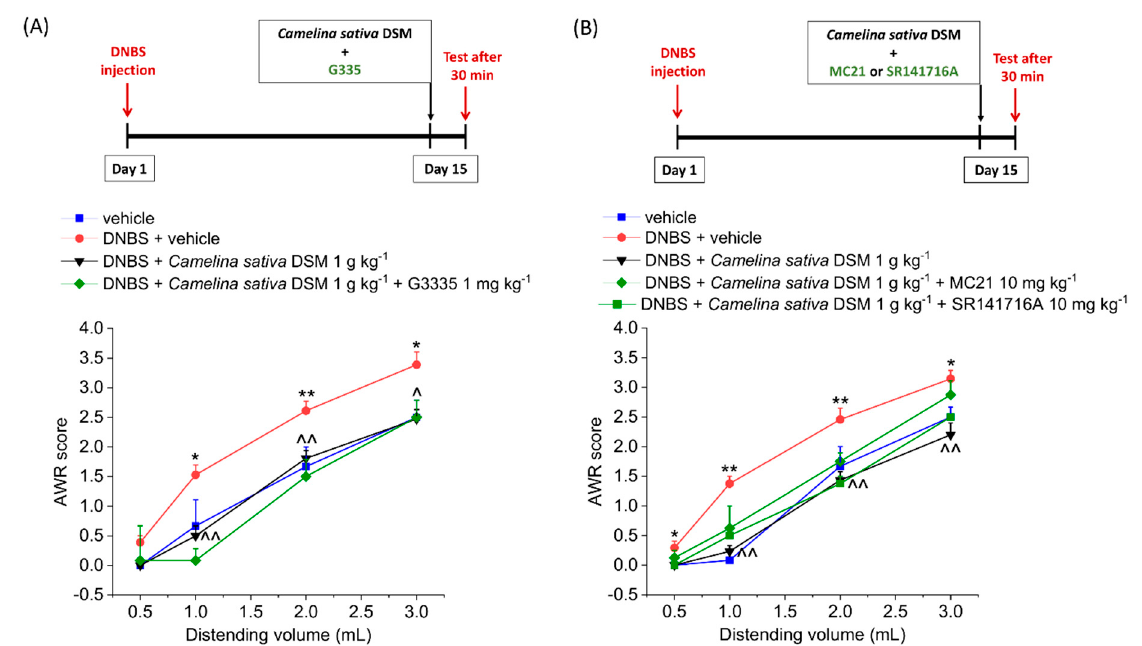
Figure 4. The involvement of PPAR- Ƴ , CB1, and CB2 receptor in the acute pain-relieving effect of Camelina sativa DSM. Visceral sensitivity was assessed in animals by measuring the extent of the abdominal withdrawal response (AWR) to colorectal distension, carried out by applying an increasing distending stimulus on the colon walls (0.5–3 mL). ( A ) The PPAR- Ƴ receptor antagonist G3335 (2 mg kg − 1 ) was intraperitoneally administered in concomitance with Camelina sativa DSM (1 g kg − 1 ), and the test was performed after 30 min. ( B ) CB1 and CB2 receptor antagonists (SR141716A and MC21, respectively; 10 mg kg − 1 ) were intraperitoneally administered in concomitance with Camelina sativa DSM (1 g kg − 1 ), and the test was performed after 30 min. Each value represents the mean ± SEM of six animals per group. * p < 0.05 and ** p < 0.01 vs. vehicle. ^ p < 0.05 and ^^ p < 0.01 vs. DNBS +